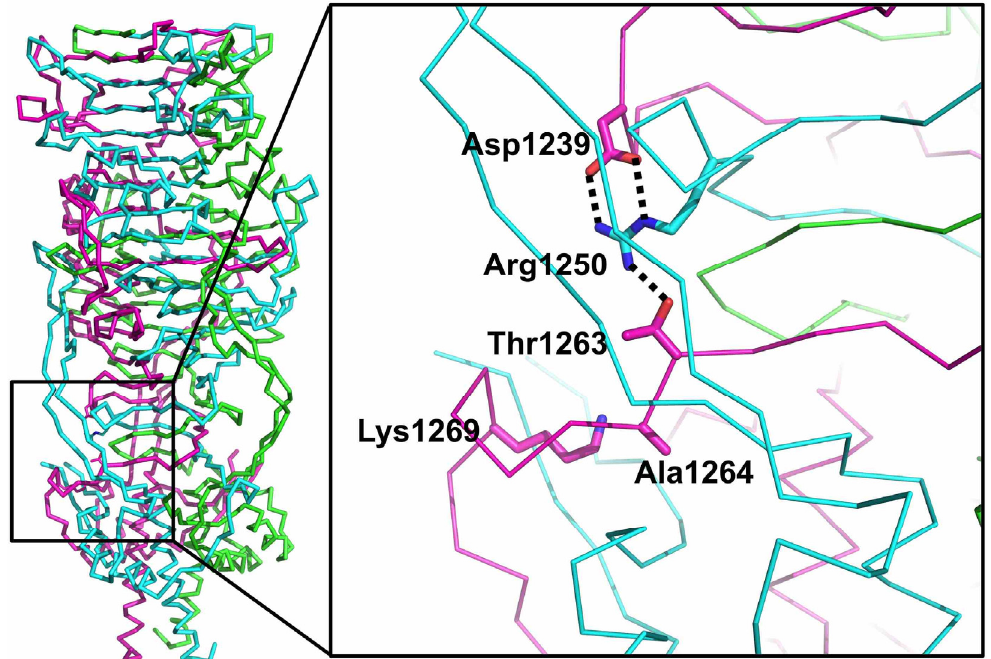
Figure 6. Residues proposed to be involved in the proteolytic cleavage reaction. The location of the guanidine group of Arg1250 of a neighbouring protein chain between the side-chains of Asp1239 and Thr1263 is shown. The catalytic Ser1264 would be where Ala1264 is in the structure of the uncleaved mutant protein. Lys1269 is also highlighted.